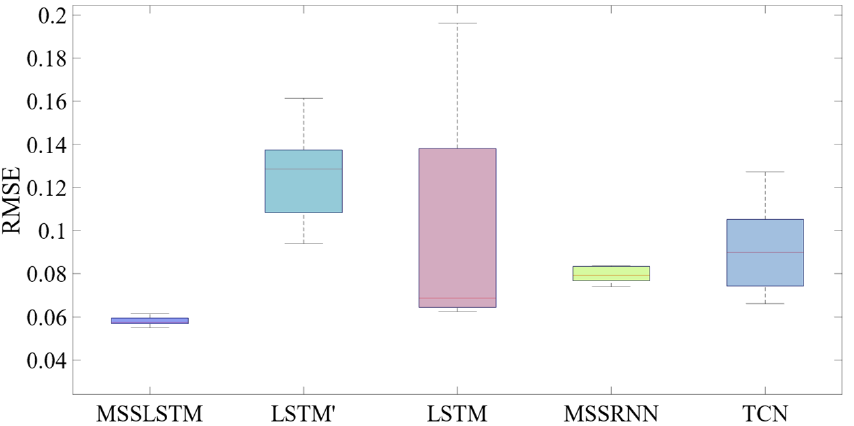
Figure 12. The RMSE distribution diagram of the ten-time experiments.